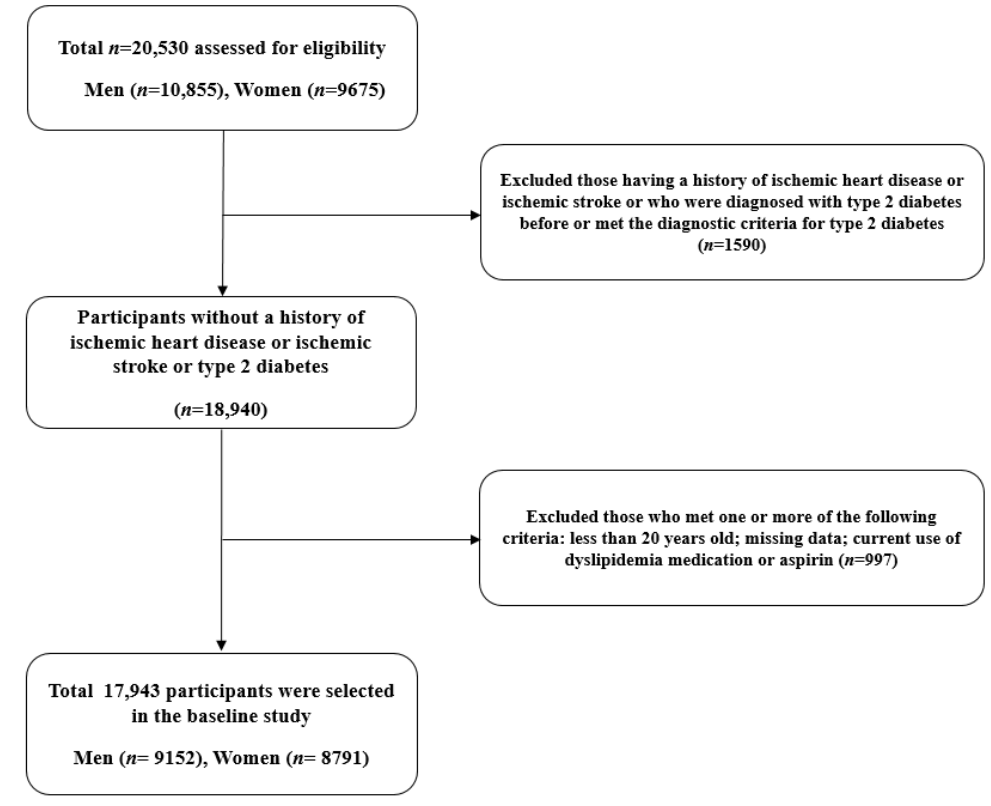
Figure 1. Flowchart for the selection of study participants.